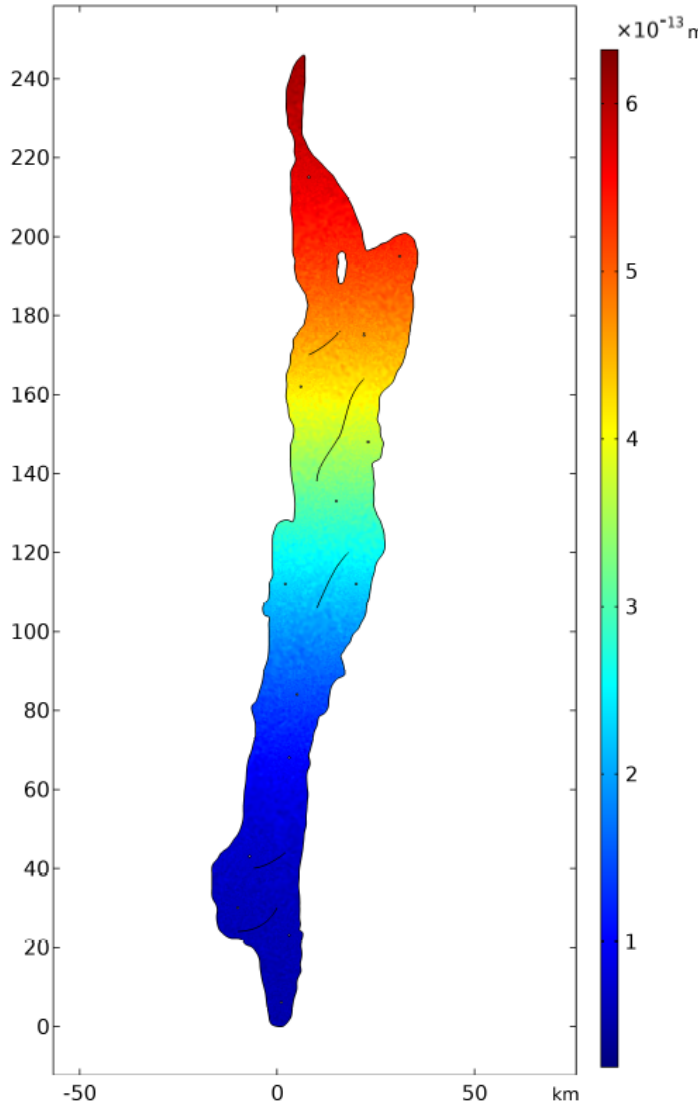
Figure 10. Absolute permeability field of the Ghawar field used during the